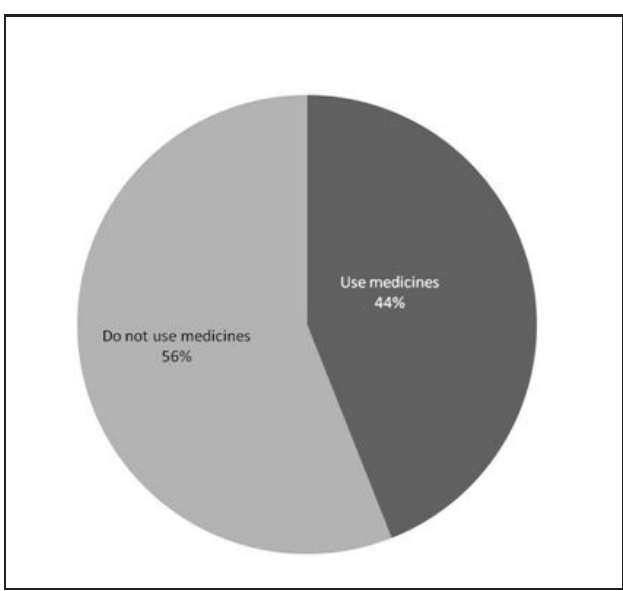
Fig. 2: Distribution of the Unified Health System users according to continuous allopathic drugs use in the city of Pelotas-RS,